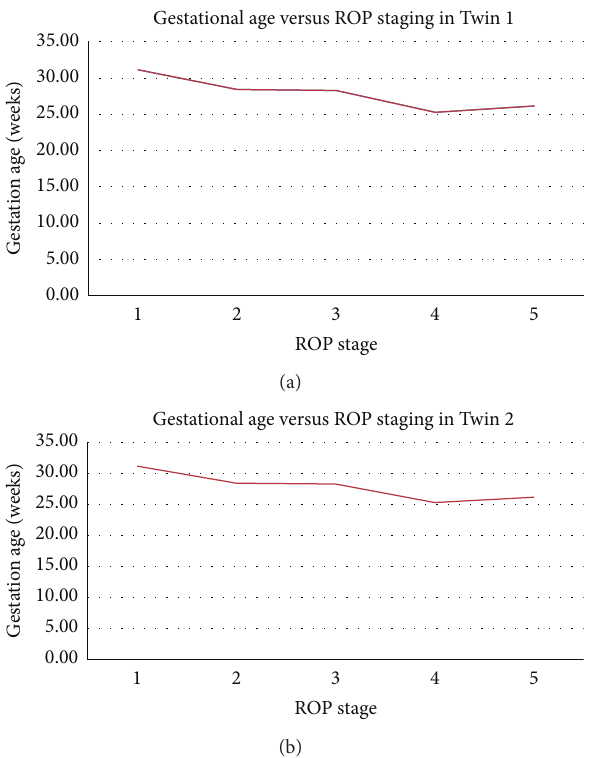
Figure 1: Gestational age versus ROP stage in Twins 1 and 2.